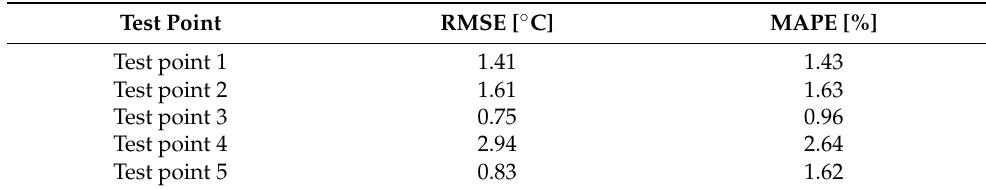
Table 3. Numerical results of the validation process of the CFD